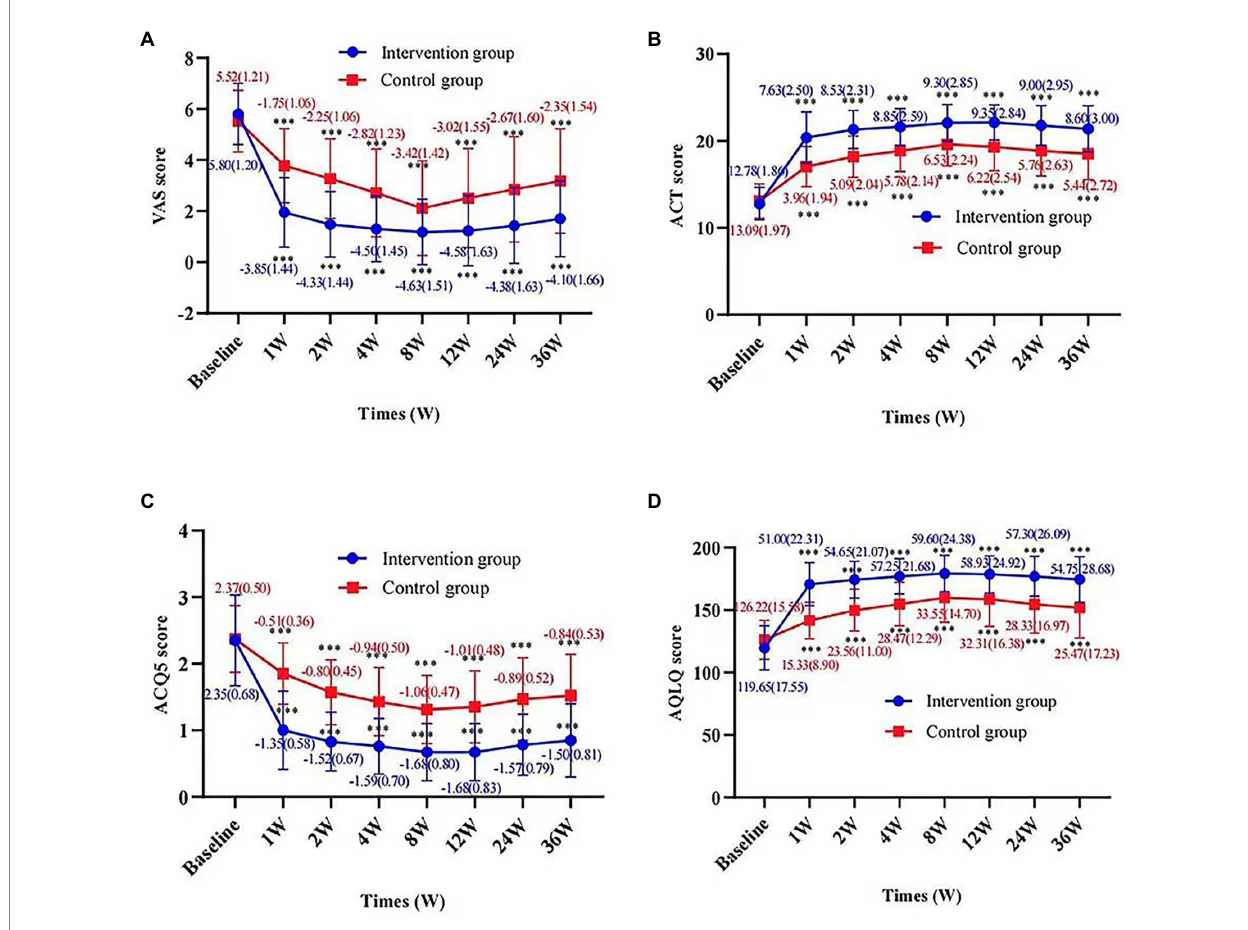
FIGURE 4 Change in VAS score, ACT score, ACQ5 score, and AQLQ score according to times and groups. Figures show the difference in VAS score (A) , ACT score (B) , ACQ5 score (C) , and AQLQ score (D) at each time point from baseline for the intervention and control groups, respectively. Values are presented as mean (SD). p value represents a paired sample t -test for the change from baseline in the two groups. *** p value <0.001, compared with baseline.